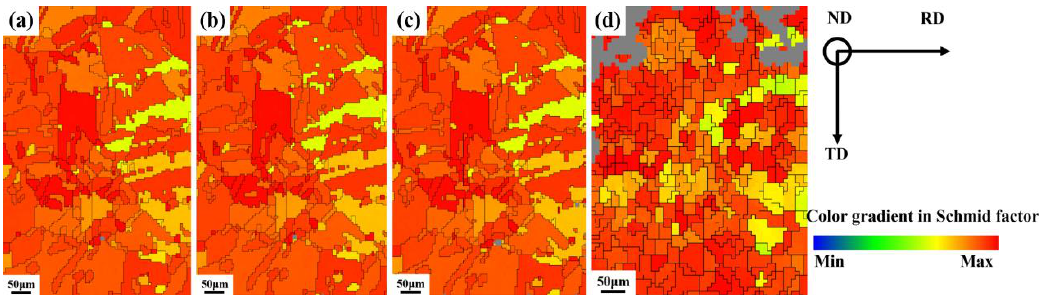
Figure 10. Schmid factor map of the same region of the specimen at various true strains: ( a ) 0, ( b ) 0.009, ( c ) 0.024, ( d ) 0.09 (RD: rolling direction, ND: normal direction, and TD: transverse direction).